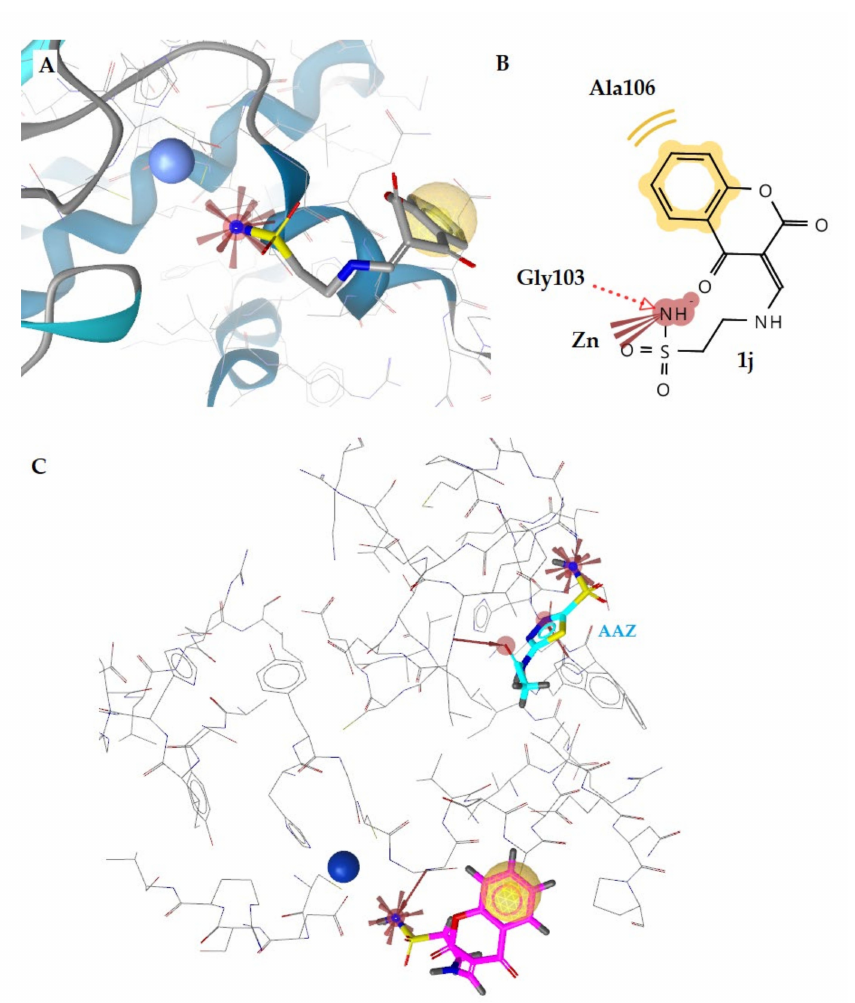
Figure 8. ( A ) Docking pose of compound 1j in E. coli β -CA enzyme. ( B ) 2D interaction diagram of compound 1j . ( C ) Superposition of compound 1j bound to E. coli β -CA enzyme (magenta) in comparison to AAZ (blue). Active-site zinc shown as blue sphere, red dotted arrows indicate H-bonds, and yellow spheres are hydrophobic